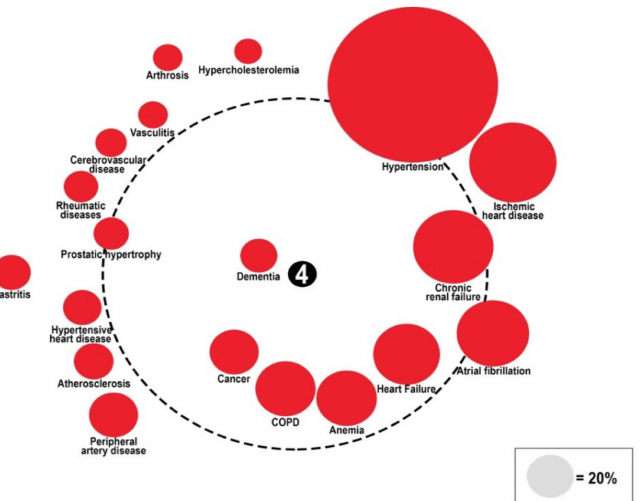
Figure 4. Comorbidome representation of in-hospital mortality in the RePoSI population with diabetes. Diameter of colored circles is function of the prevalence of each comorbidity. The dotted- line circle represents the OR equal to 1, the outside area corresponds to OR < 1, and the inner area correspond to OR > 1. All circles associated with a statistically significant increase in mortality are fully inside the dotted orbit. Mortality is set at the center (with the higher value = 4). The proximity to the center represents the stronger positive association with mortality. The comorbidities are represented graphically clockwise, from the first with the higher prevalence to the last with the lower prevalence in patients with diabetes.